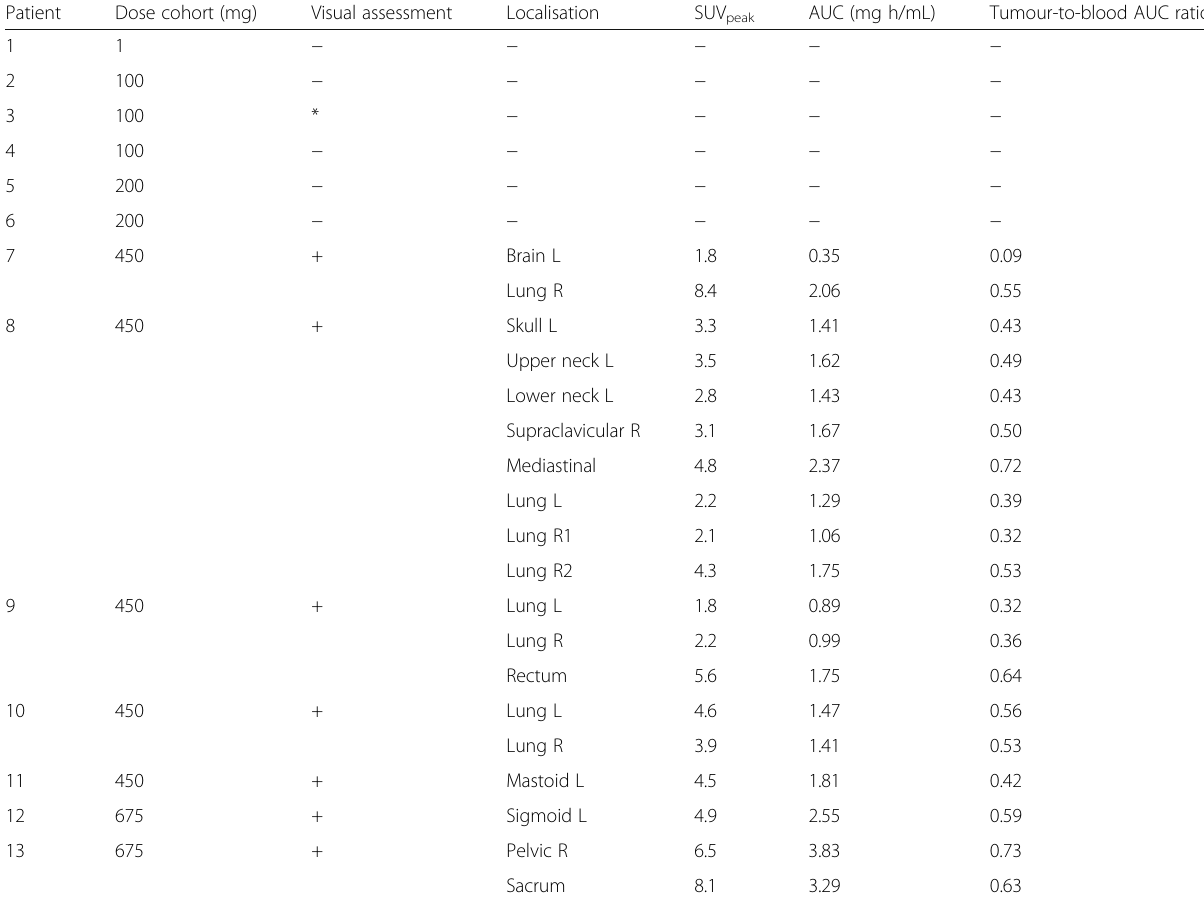
Table 2 Tumour uptake of 89 Zr-RG7356 and RG7356 at 96 h p.i.